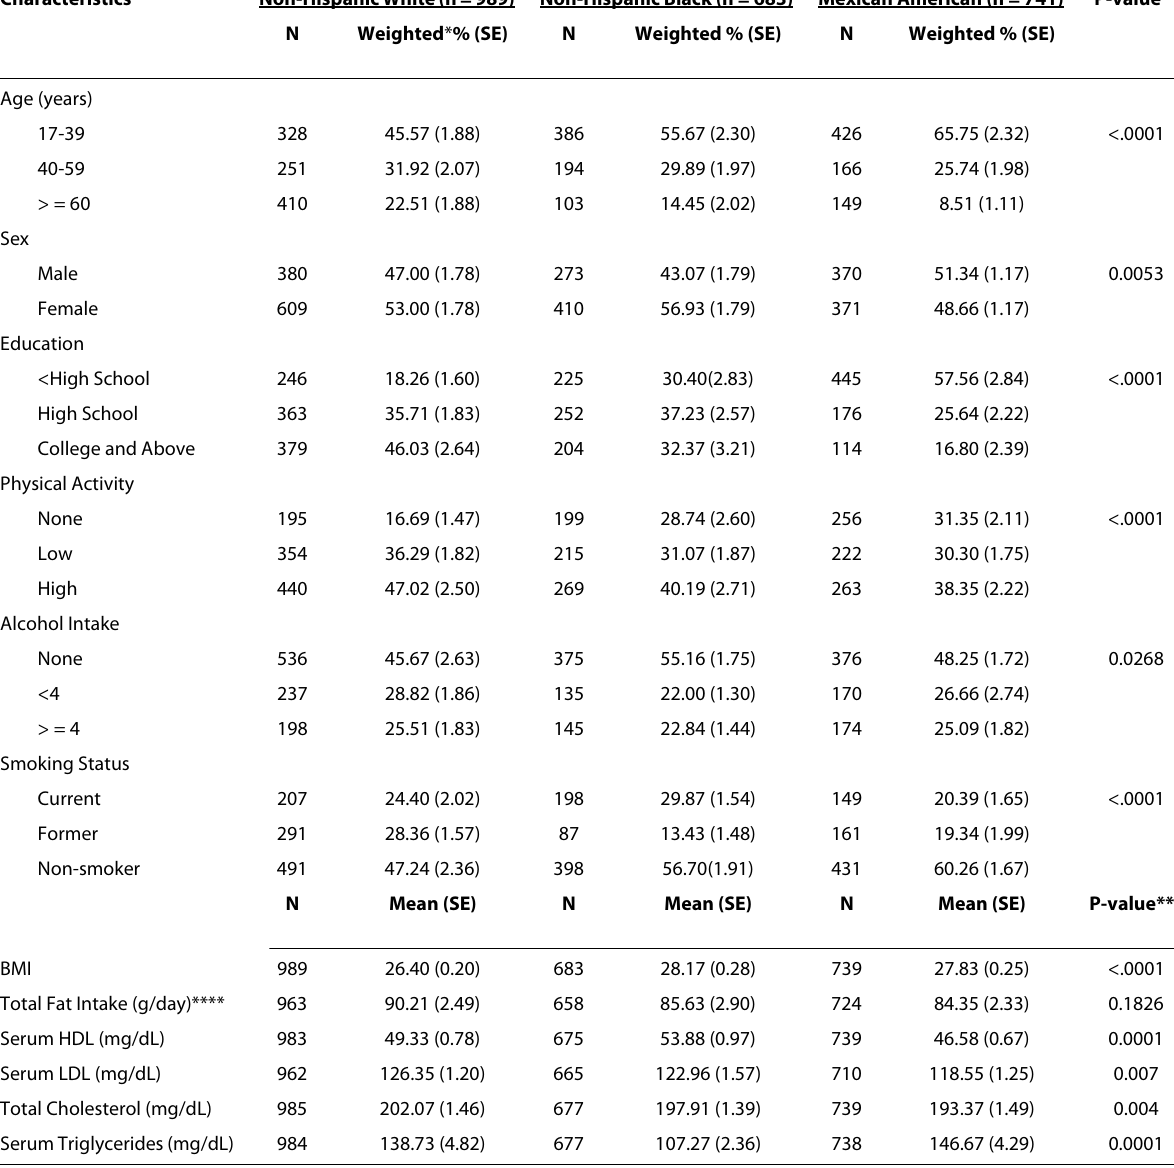
Table 1: Characteristics of study fasting samples - NHANES III (1991-1994) Characteristics